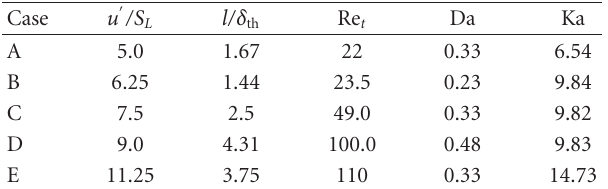
Table 1: List of initial simulation parameters and non-dimensional